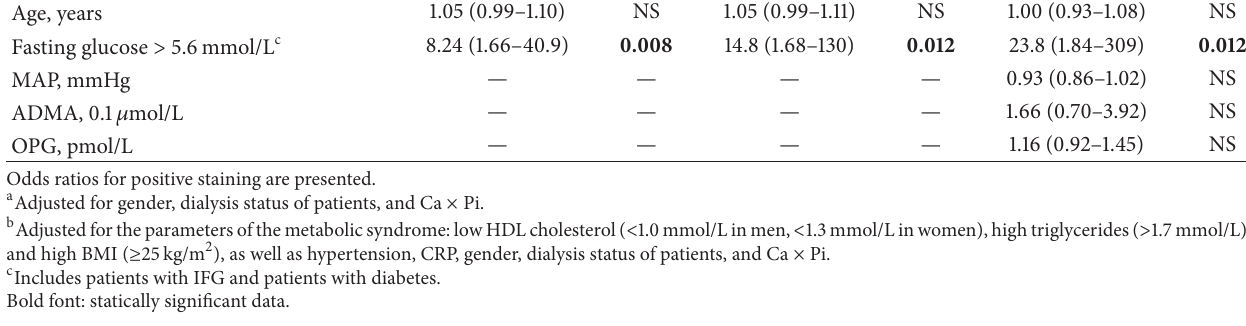
Table 2: Differences in clinical criteria of the metabolic syndrome between patients with and without vascular calcifications as assessed by alizarin red staining of the radial artery. BMI > 25kg/m 2 (overweight or obesity), 𝑁 (%) 18 (53%) 14 (56%)